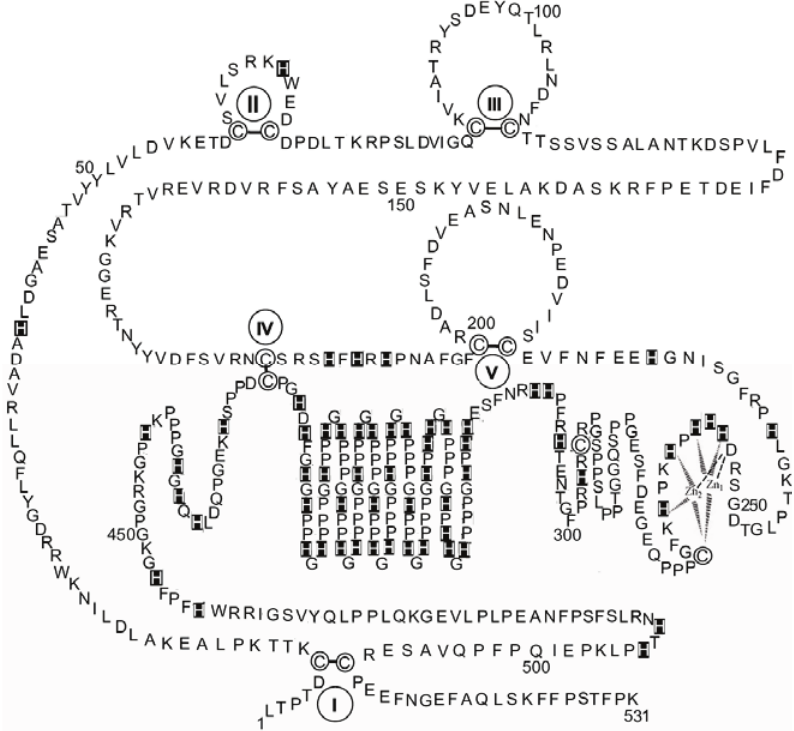
Figure 3. The primary structure of rabbit HPRG. The disulphide bonds are indicated by Roman numerals. His residues are marked. Proposed interactions are shown between two Zn ions and the amino acids localised between residues 253 and 265 in the putative specific dinuclear zinc binding